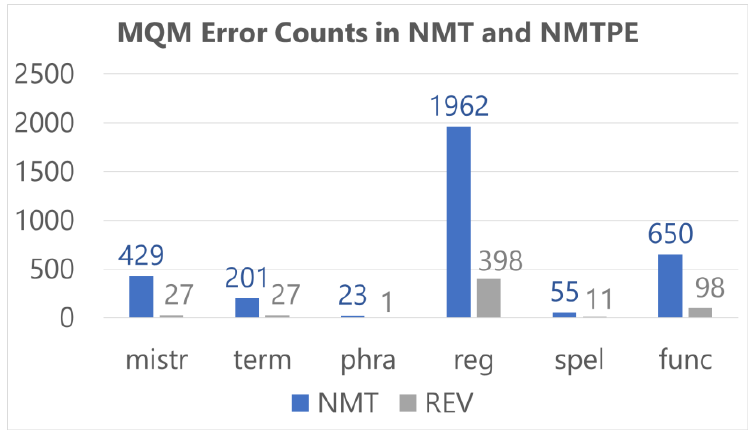
Figure 2. Error distribution after manual MQM annotation of NMT.